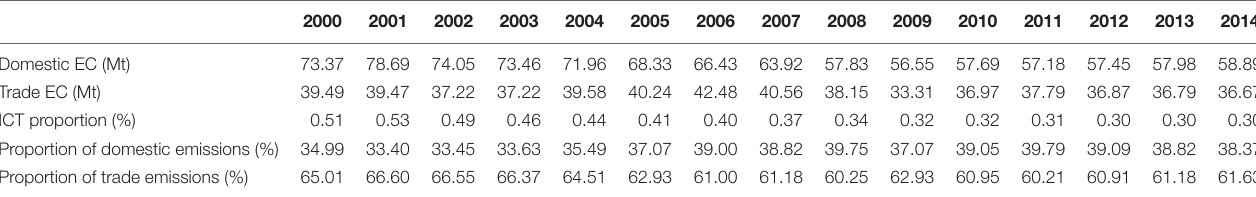
TABLE 3 | Information and communication technologies domestic and trade carbon emissions and its